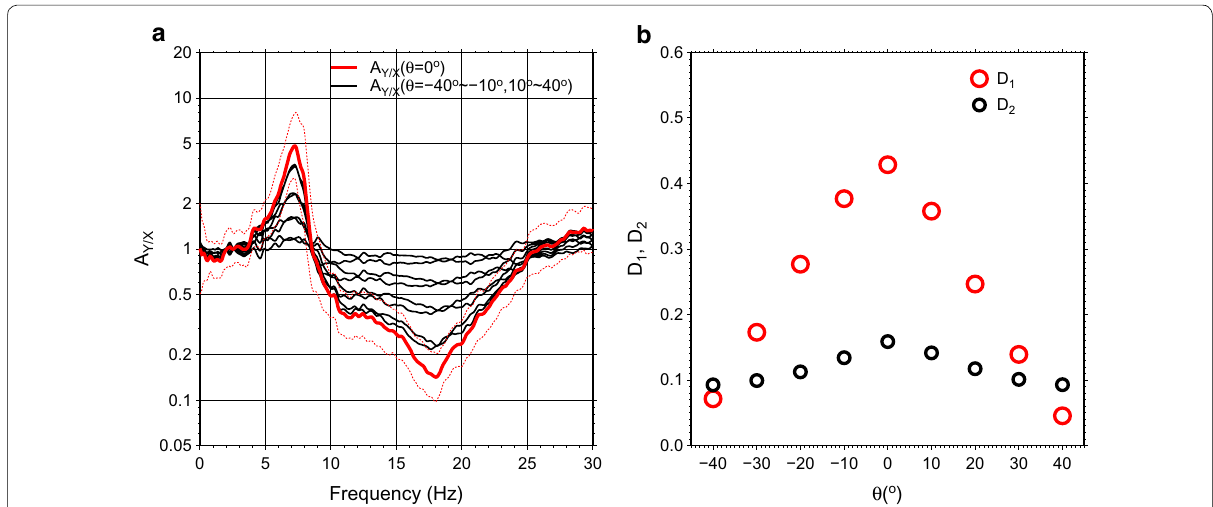
Fig. 3 Rotation angle θ dependence of ( a ) average Y/X amplitude spectral ratio and ( b ) D 1 (red circles) and D 2 (black circles) values obtained for station N.S6N14. Red and thin black curves in a represent amplitude spectral ratios for θ respectively. Red dotted curves are logarithmic standard deviation of the Y/X amplitude spectral ratio for θ